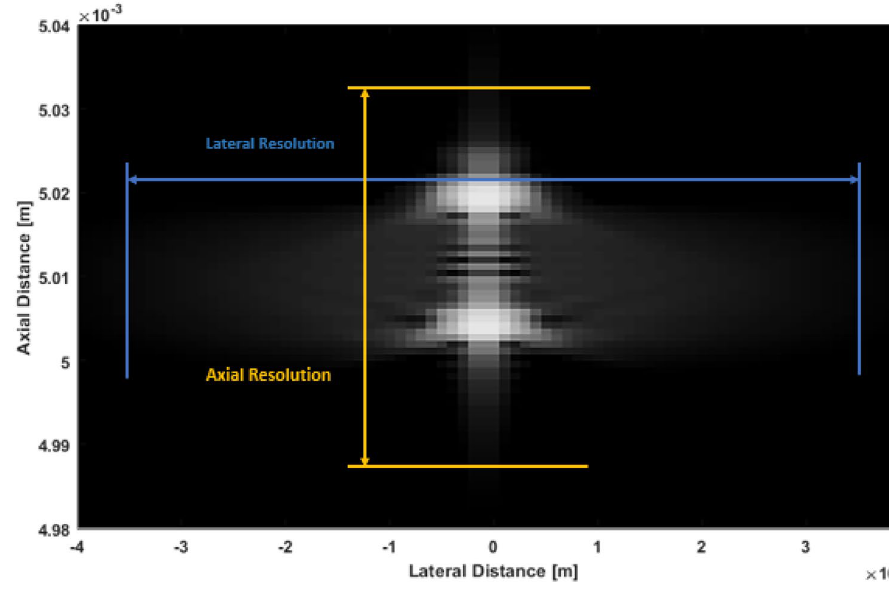
Fig. 8 The pressure profile in response to impulse voltage resulting from the KLM model for the optimized